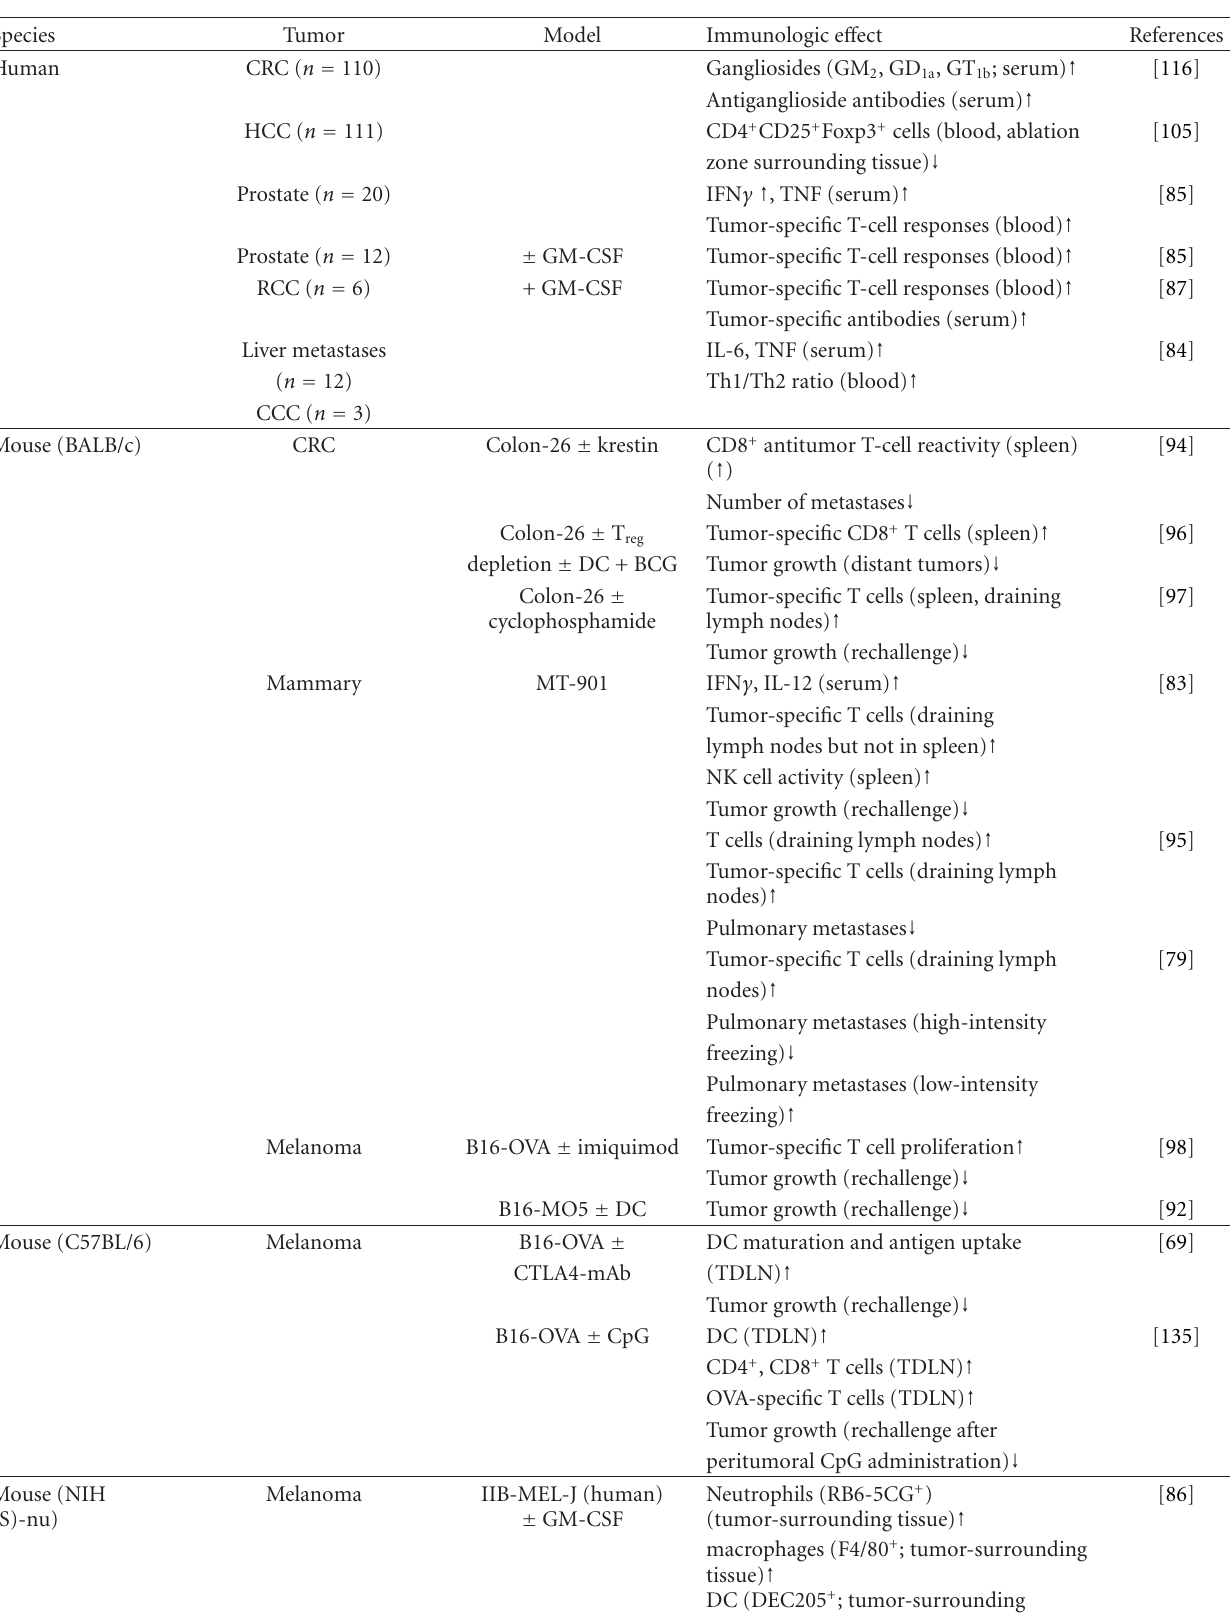
Table 3: Recent Studies reporting immune modulation in cancer patients and animal models treated with cryoablation.